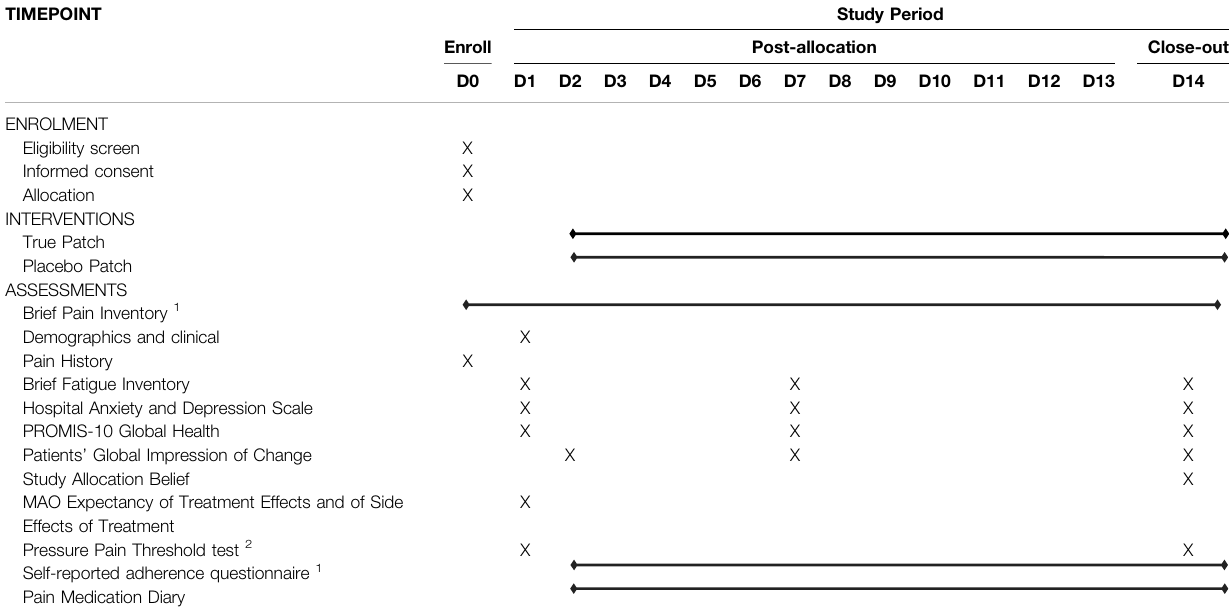
TABLE 2 | Study Schedule